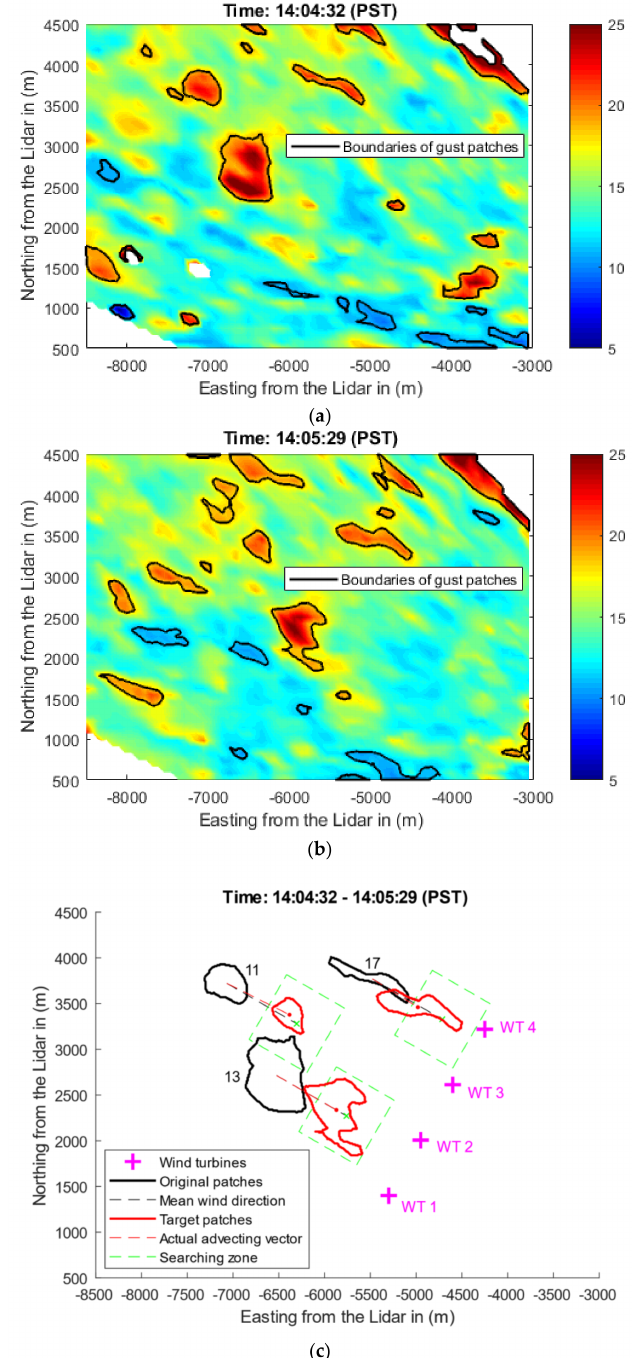
Figure 5. ( a ) Wind field at the first time frame. Colors indicate the wind speed. Black contours are the boundaries of detected patches; ( b ) Wind field at the second time frame; ( c ) Example original- target patch pairs. Black patches are the original gust regions extracted from ( a ), and red patches are the corresponding target gust regions extracted from ( b ). Green dashed boxes are the searching zones. Black and red dashed lines indicate the moving direction of the streamline and the real movement of the patches, respectively. Pink crosses indicate the locations of a virtual wind turbine